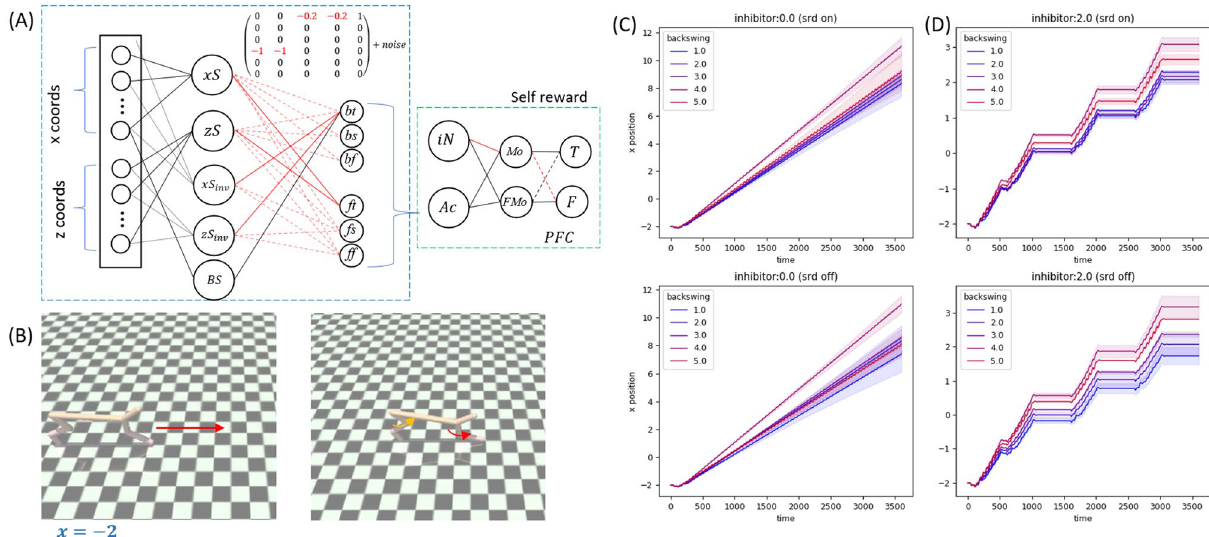
Figure 6. ( A ) The HalfCheetahSRD, the neural network model used to move MuJoCo half-cheetah. ( B ) Half cheetah starts at position x = − 2 . Red/orange curved arrows denote the swings of front/rear thighs. ( C ) mean x position over time for different magnitudes of backswing . ( D ) Same as ( C ), but with inhibitor set to 2, allowing the agent to response the instruction to stop